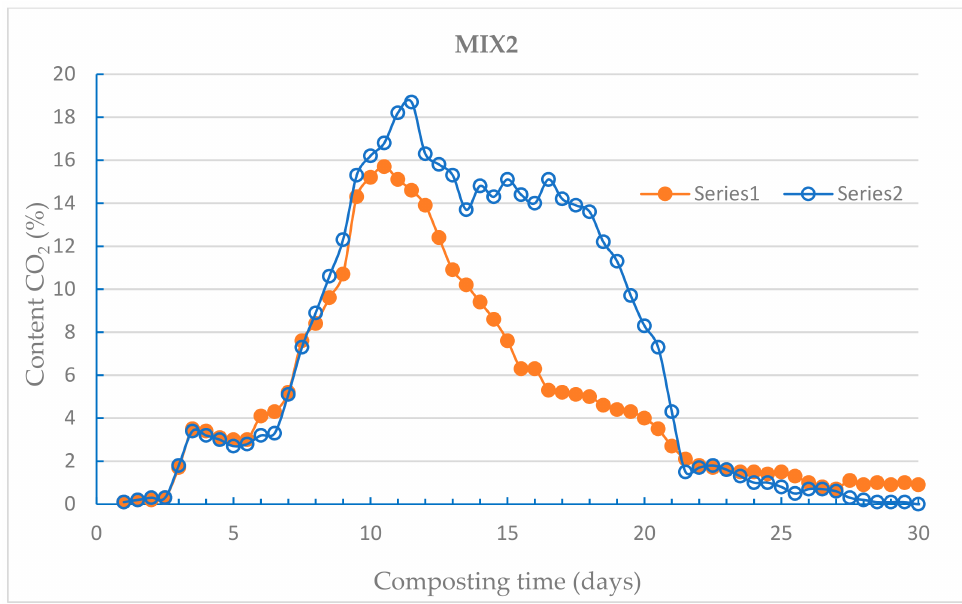
Figure 6. Changes in content CO 2 during the composting of MIX2.